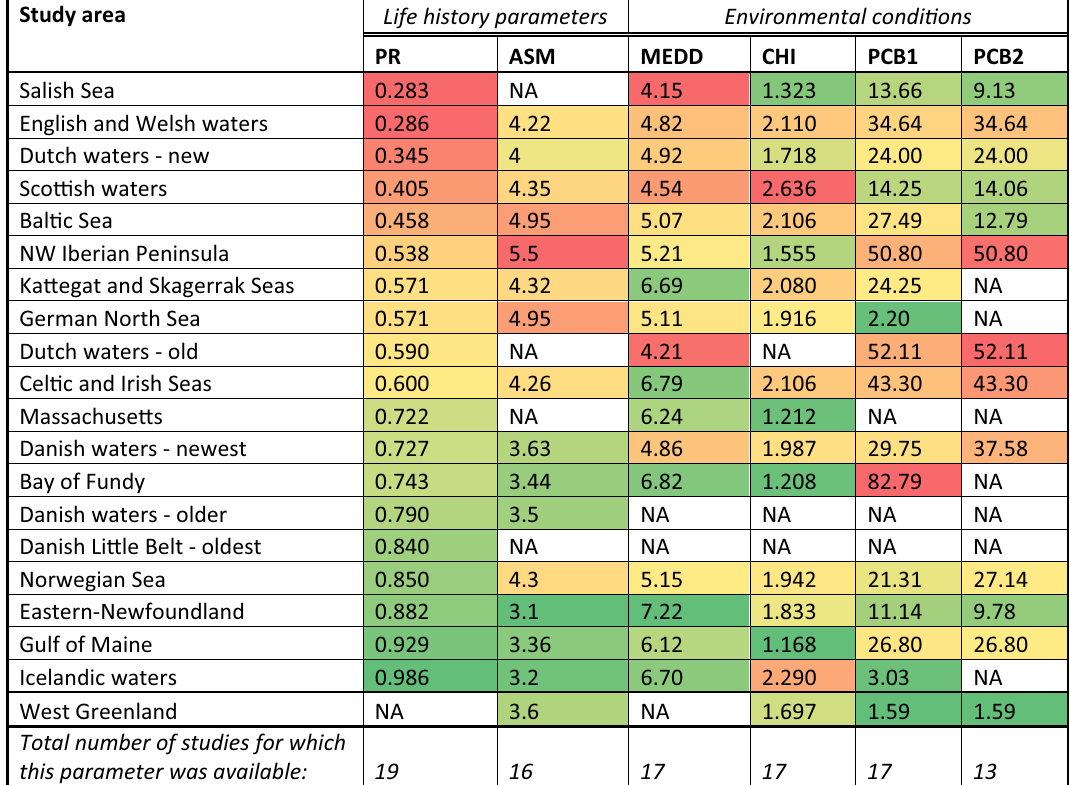
Table 2. Summary table of pregnancy rates (PR), age at sexual maturity (ASM), mean energy density of diet (MEDD), cumulative human impact (CHI) mean scores, and chemical pollution by PCBs (mg/kg lipid weight) of harbour porpoises in study areas across their distributional range. Note that PCB is given twice; PCB1 is without restrictions on the sum of congeners and mixtures reported, and PCB2 is restricted to studies reporting ≥ ∑17PCB− ≤ ∑99PCB. The table is organized by study area arranged from lowest to highest PR with colour shadings corresponding to lowest (reddest) to highest (greenest) PR. All entries of the other columns are coloured as highest (reddest) to lowest (greenest). Time frames of studies and references are given in STab.